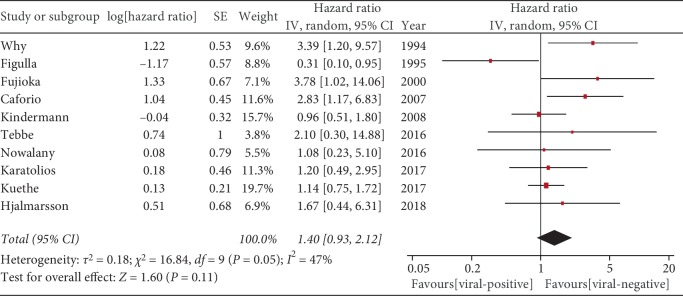
Prognosis in virus-positive versus virus-negative.